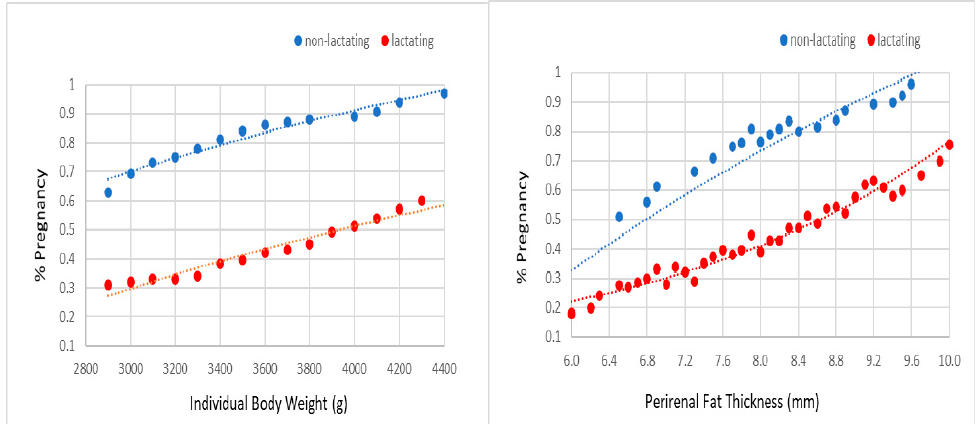
Figure 3. Probability of pregnancy at third gestation on individual body weight and perirenal fat thickness at 10 day after delivery (i.e., third mating, in lactating and non-lactating